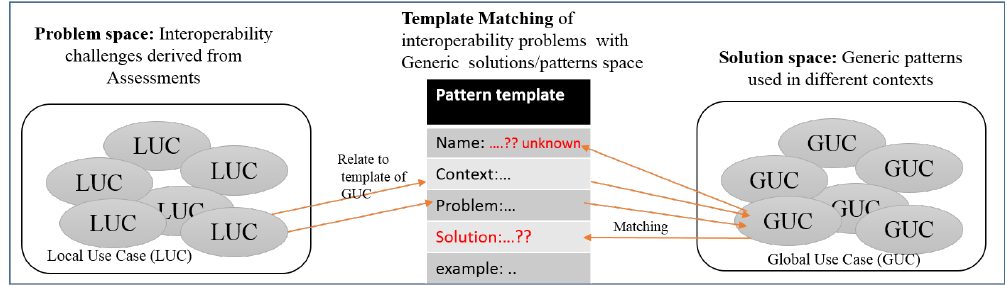
Figure 6. Problem and solution matching resulting into reusable patterns, i.e., “interoperability patterns”.